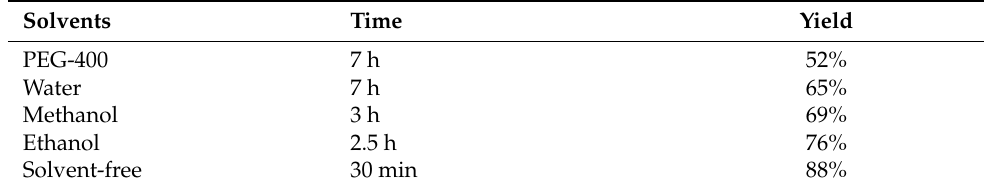
Scheme 2. Schematic diagram for the synthesis of dicoumarol 4 . Table 1. Effect of various solvents on the